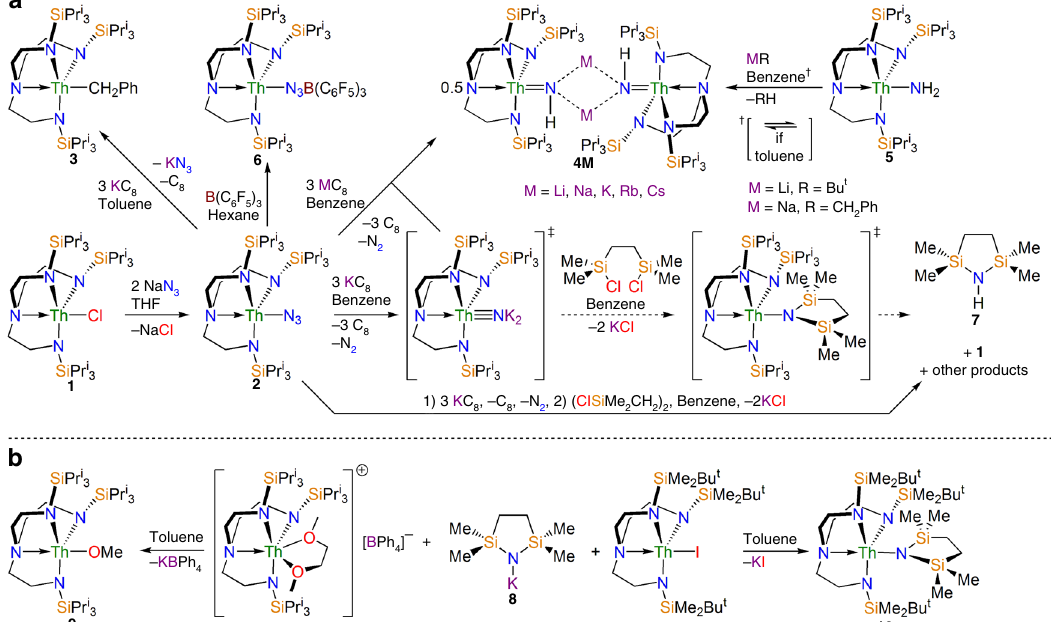
Fig. 1 Synthesis of the compounds reported in this study. a Treatment of 1 with sodium azide produces the thorium-azide 2 , which when reduced in